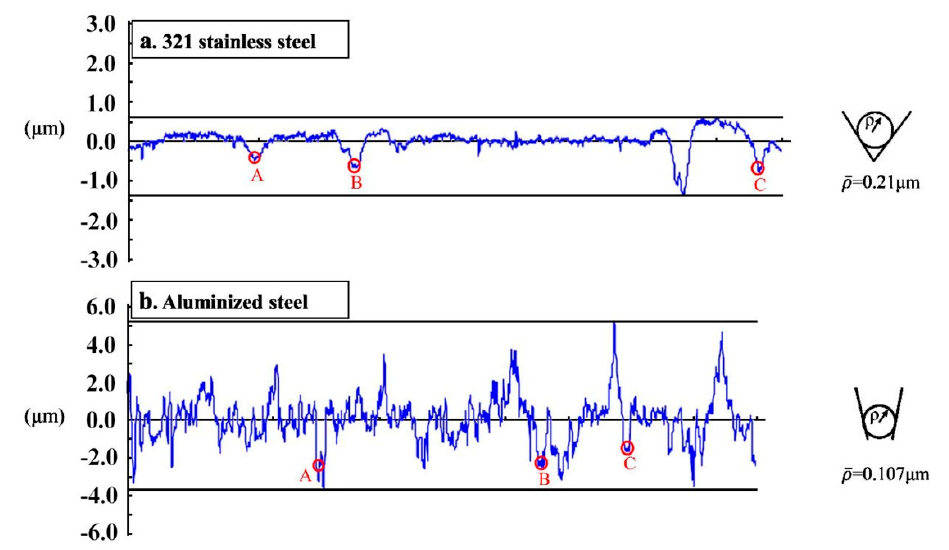
Figure 11. 2D surface texture and effective profile valley radii of ( a ) as-received sample and ( b ) aluminized sample.